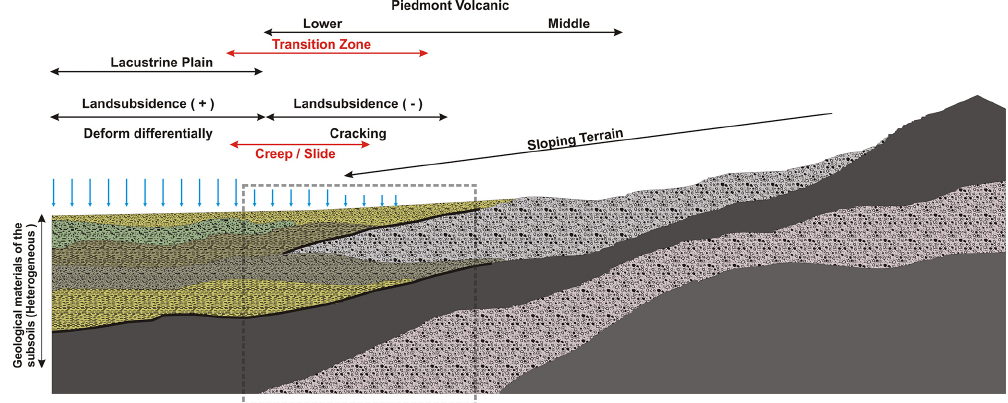
Figure 3. Schematic geological section of the piedmont zones in the Santa Catarina Range. Phenomena of land subsidence in the lacustrine plain (left) associated with mass movements processes (right) over a detachment surface are shown.